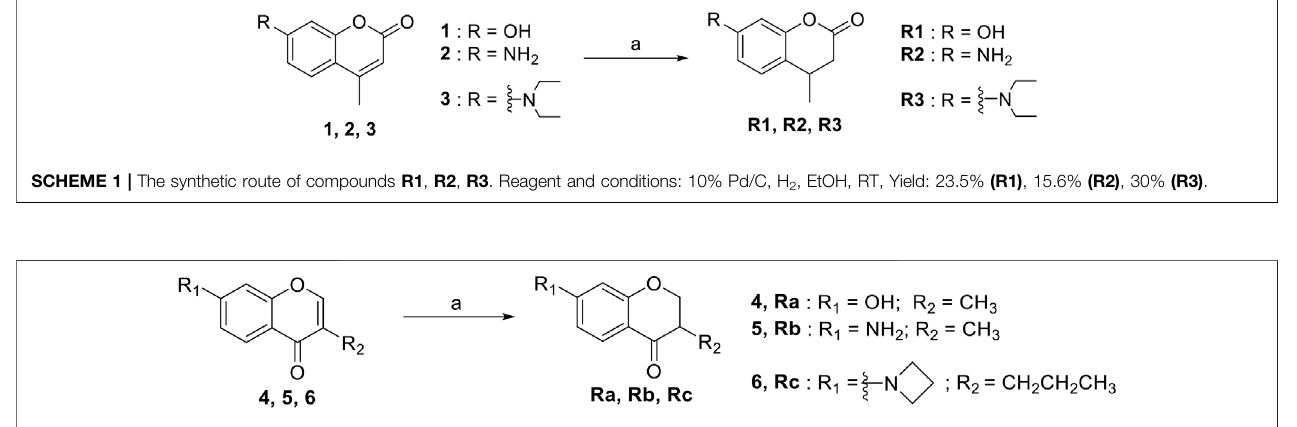
SCHEME 2 | The synthetic routes of compounds Ra , Rb , Rc . Reagent and conditions: LiAlH 4 , dry THF, − 20 ° C. Yield: 46.2% (Ra) , 29.3% (Rb) , 60.3% (Rc) .